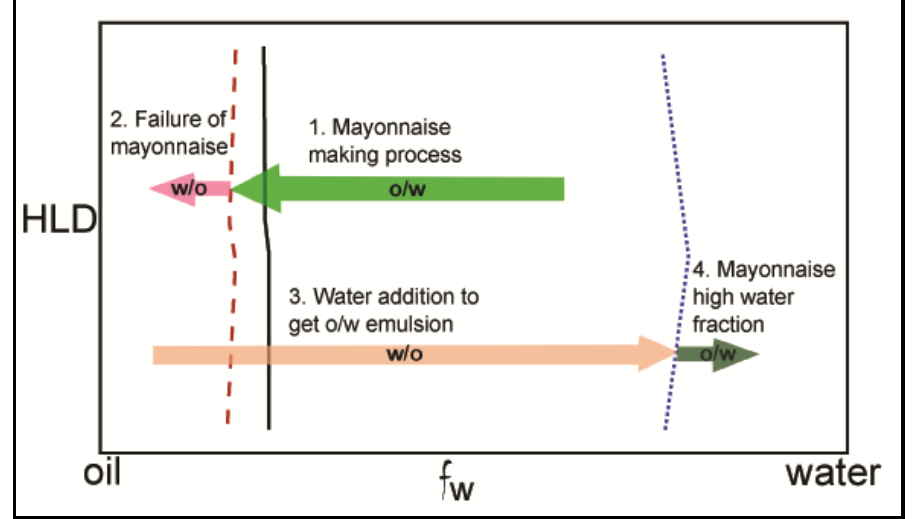
Figure 5. Schematic presentation of mayonnaise making process. Catastrophic inversion lines (—) at direct emulsification; and at dynamic emulsification (- - -) when oil is added and (…) when water is added. Reproduced with permission from Thakur et al. [86], Copyright (2008) Colloids and Surfaces A: Physicochemical and Engineering